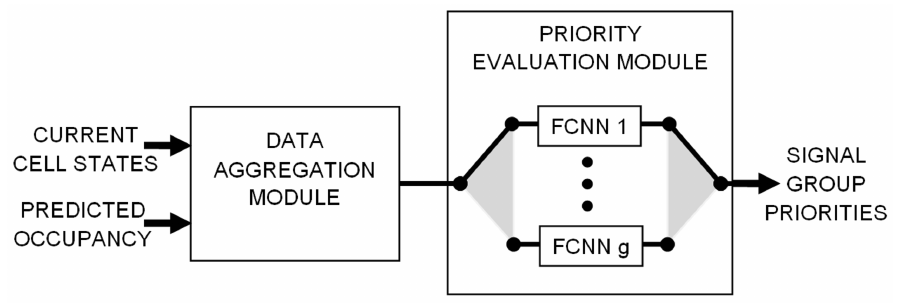
Figure 1. Structure of the neural network ensemble.